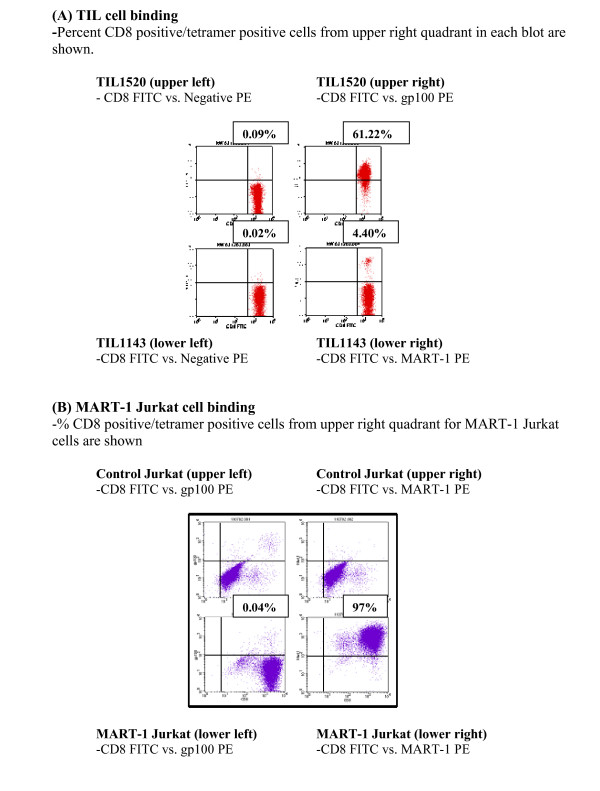
Tetramer assay specificity. (A) TIL cell binding: % tetramer positive cells are shown based on data in the upper right quadrant from each of the 4 blots. TIL1520 (top panel) were stained with negative tetramer (left) and gp100 tetramer (right). TIL1143 (bottom panel) were stained with negative tetramer (left) and MART-1 tetramer (right). (B) MART-1 Jurkat cell binding: % tetramer positive cells are shown based on data in the upper right quadrant from MART-1 Jurkat cell blots (lower panel) stained with irrelevant gp100 tetramer (left) or relevant MART-1 tetramer (right). Control Jukat cells (upper panel) were stained with both tetramers (% tetramer positive cells are <0.05%, data not shown).